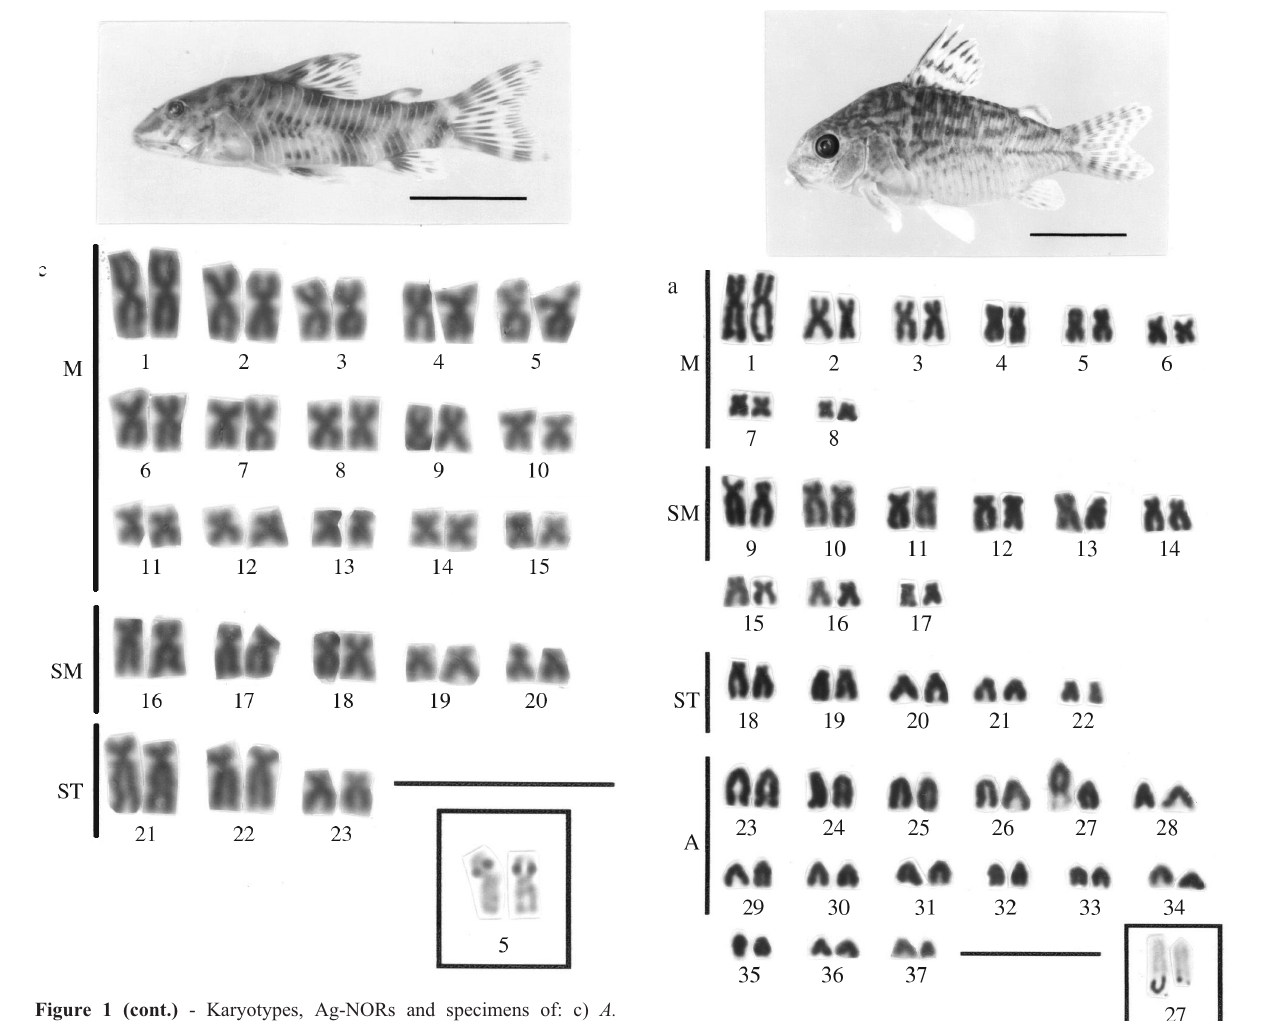
Figure 1 (cont.) - Karyotypes, Ag-NORs and specimens of: c) A. poecilus ,2n=46.Scalebars:10 µ m(karyotype)and10mm(specimen).